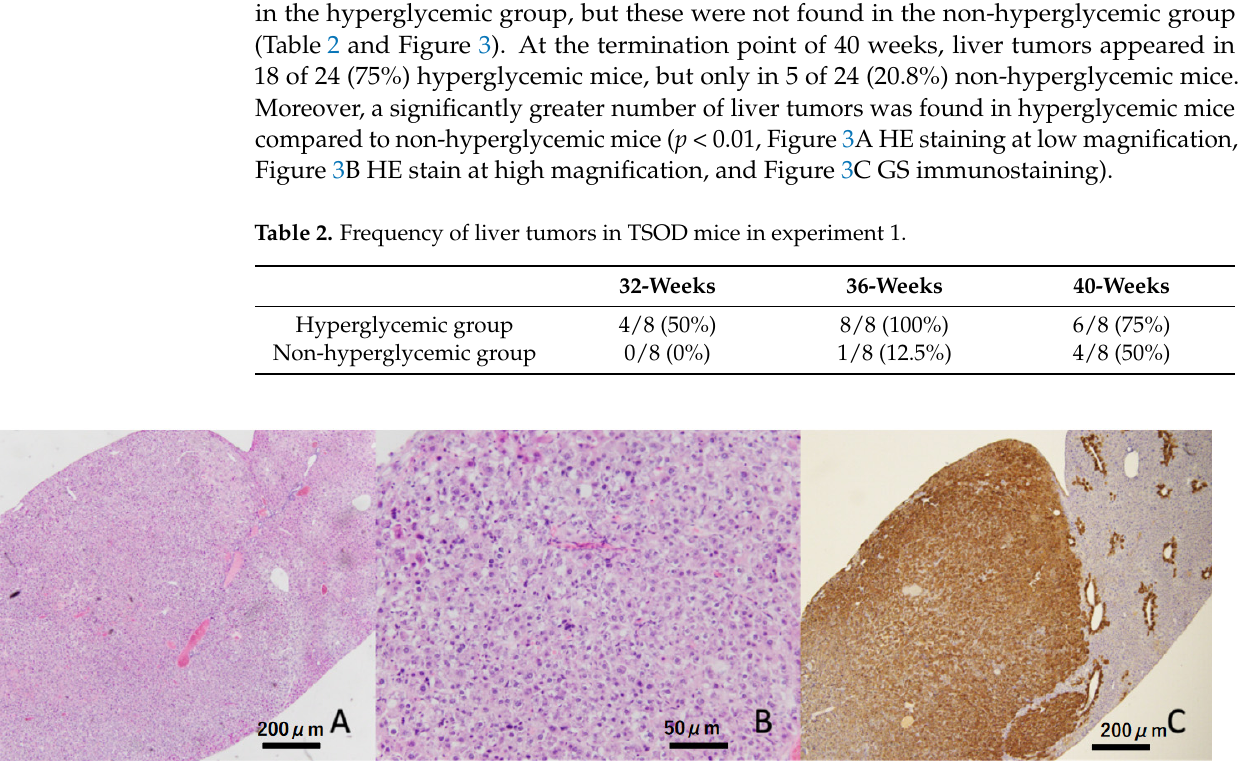
Figure 3. Representative image of the liver tumor. Liver tumor was constructed by atypical hepatocytes (HE staining). These tumors showed diffuse expressions of glutamine synthetase (GS). Scale bar: ( A ), ( C ) 200 μ m, ( B ) 50 μ m.